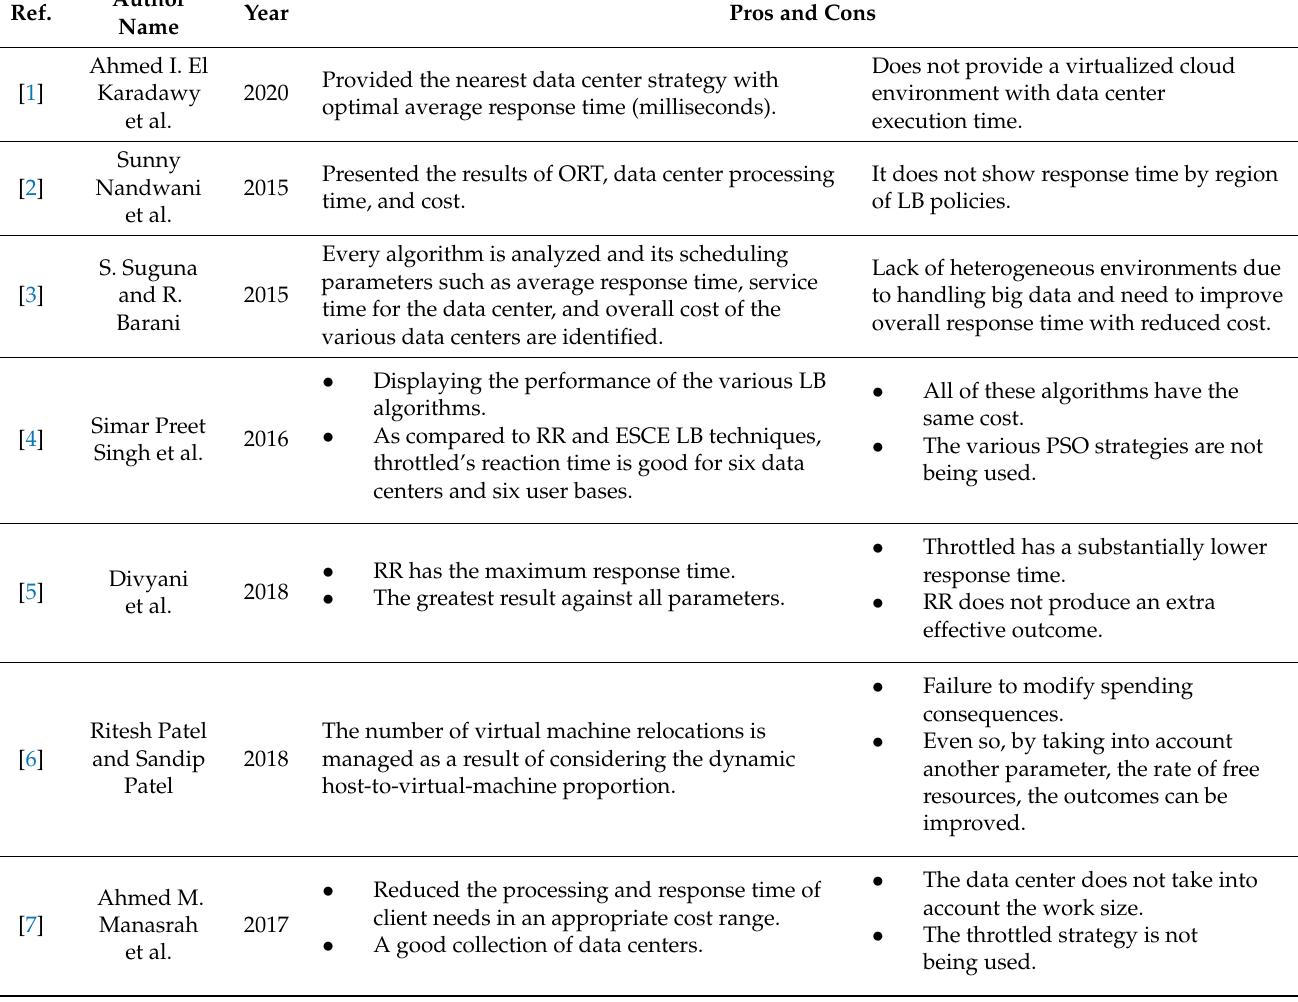
Table 1. A summary of the literature on load-balancing algorithms in cloud computing environments.